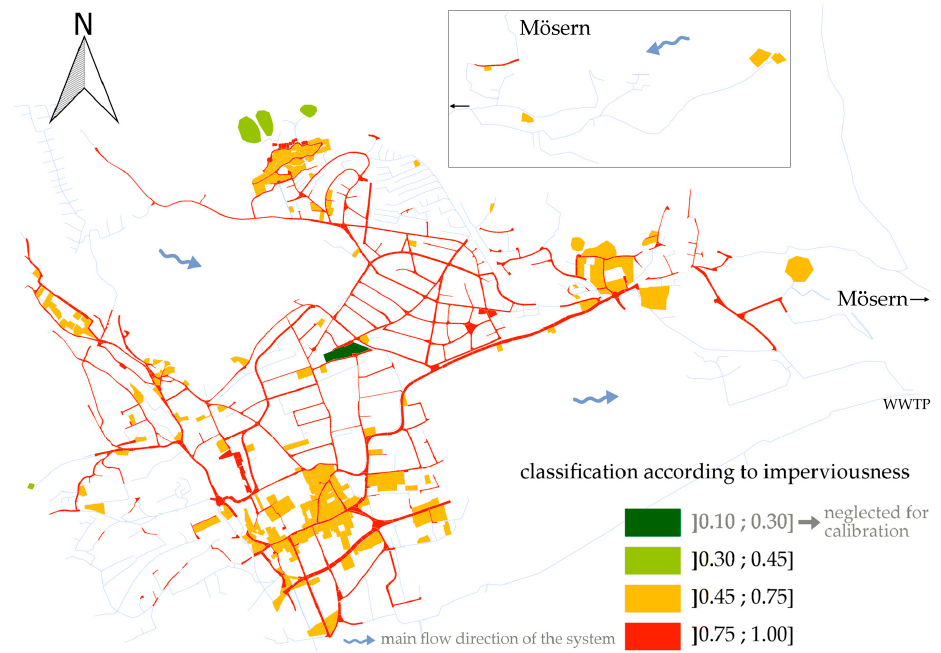
Figure 2. Classification of the subcatchments according to their initial imperviousness.